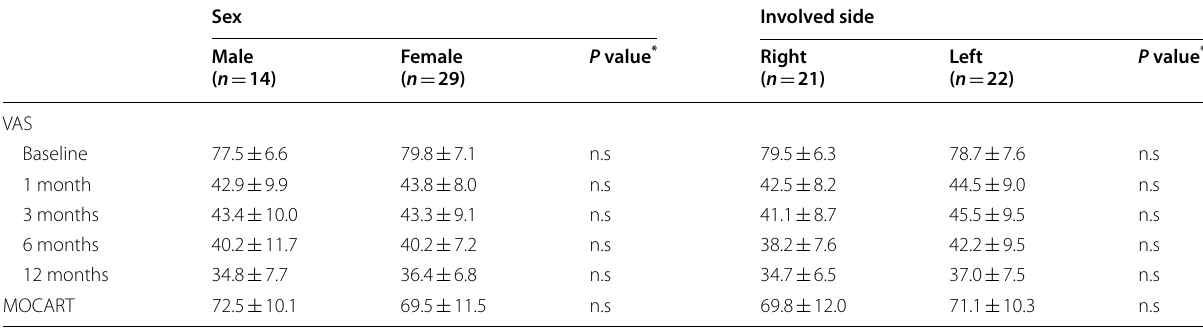
Data are presented as means standard deviation ± MOCART Magnetic resonance observation of cartilage repair tissue, VAS Visual analogue scale * Mann–Whitney U